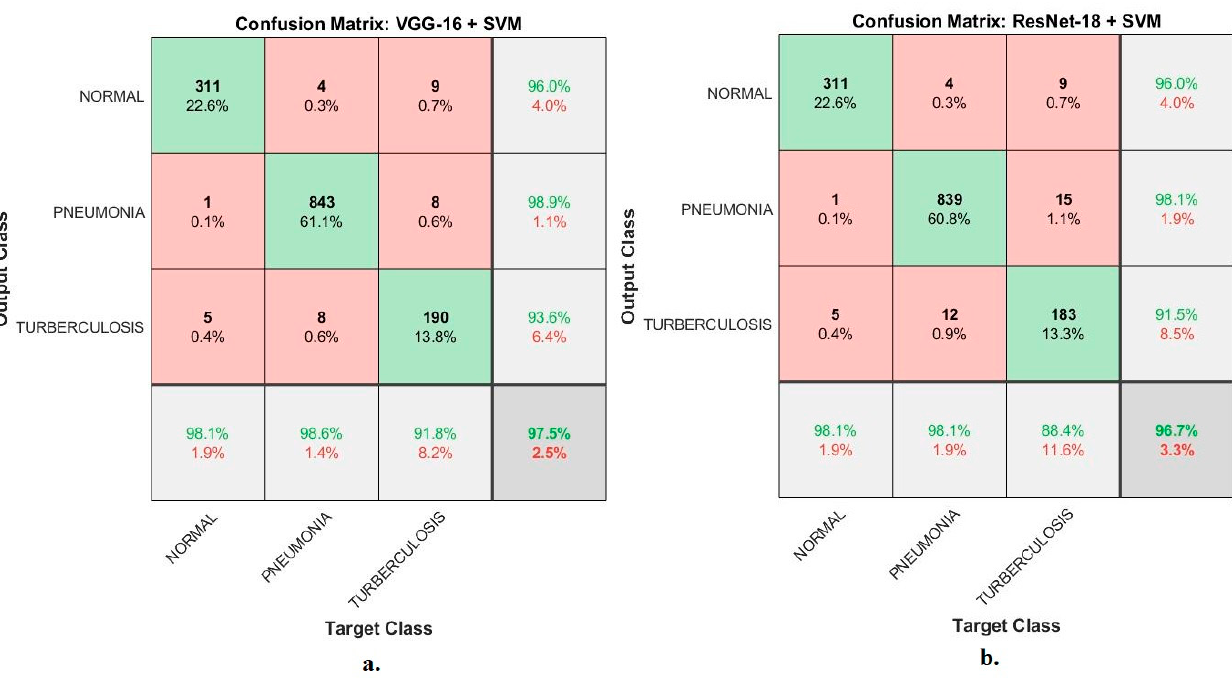
Figure 8. The confusion matrix displays the X ‐ ray results for diagnosing pneumonia and tuberculo ‐ sis using ( a ). VGG16 + SVM; ( b ). ResNet18 +